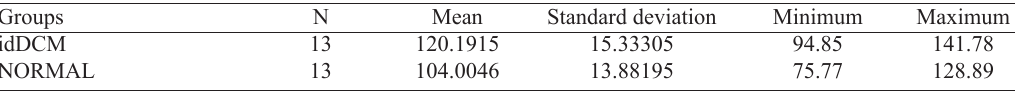
Table 3. Descriptive measures of variables RVR ring perimeter in idDCM groups and Normal (mm). Groups